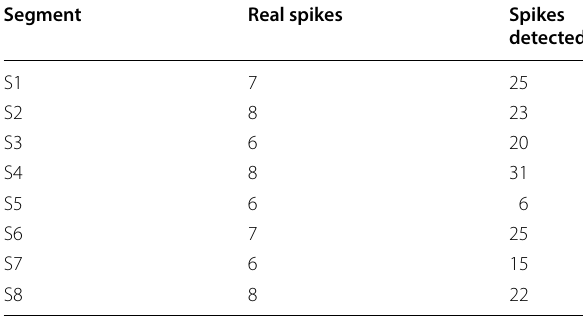
Table 1 Results of the evaluation Segment Real spikes